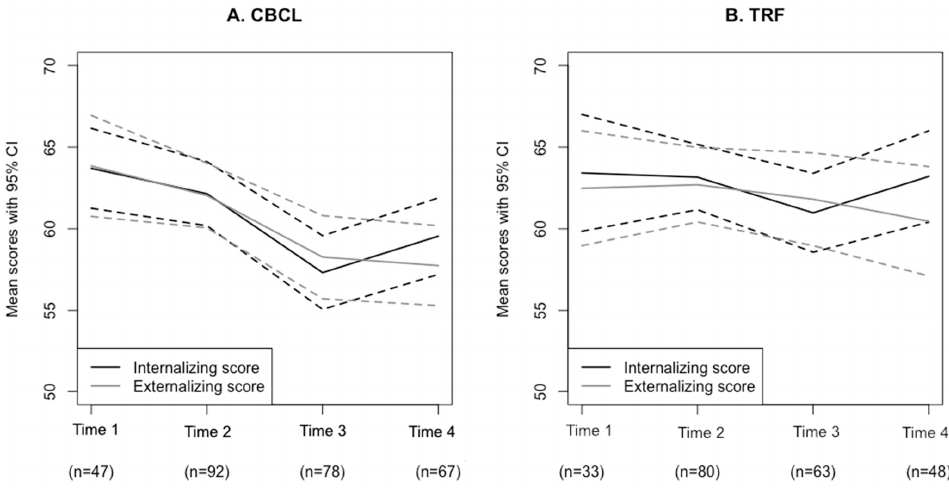
Figure 2. Change in ( A ) CBCL and ( B ) TRF outcomes between time points. Note. Time 1 = Pre- TAU (TAU + GCBT group); Time 2 = Pre-GCBT, Time 3 = Post-GCBT, and Time 4 = Follow-up (Combined group).